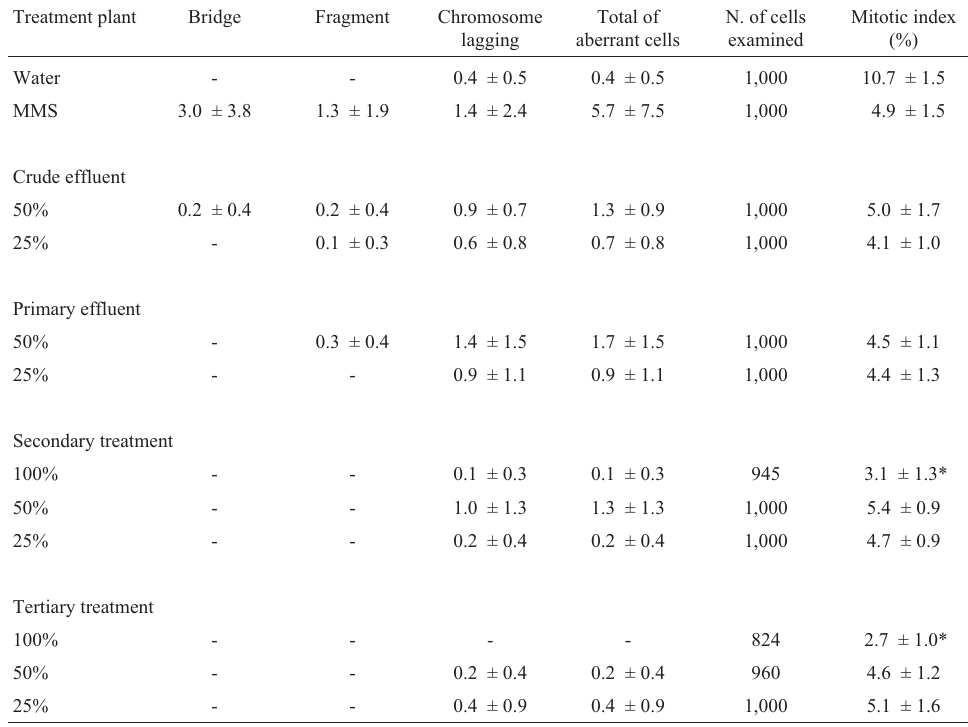
Table 2 - Allium cepa anaphase-telophase chromosome aberration assay carried out in different stages of a wastewater treatment plant. Numbers represent mean and SD in 10 onions analyzed per treatment. Treatment